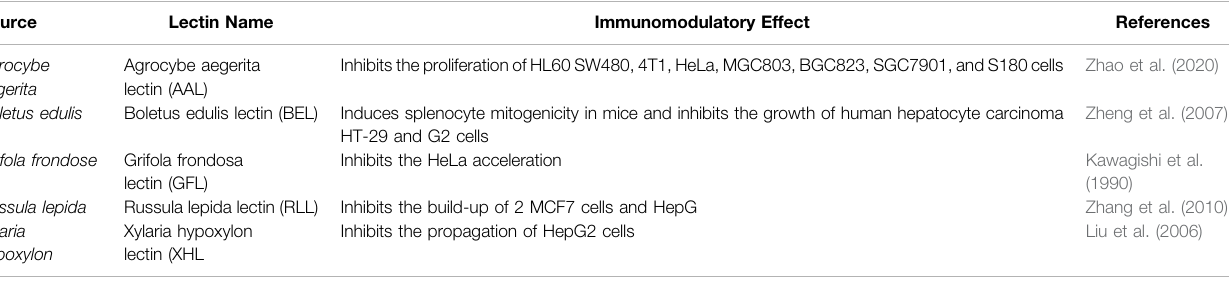
TABLE 2 | The immunoregulatory effects of lectins found in medicinal mushrooms.